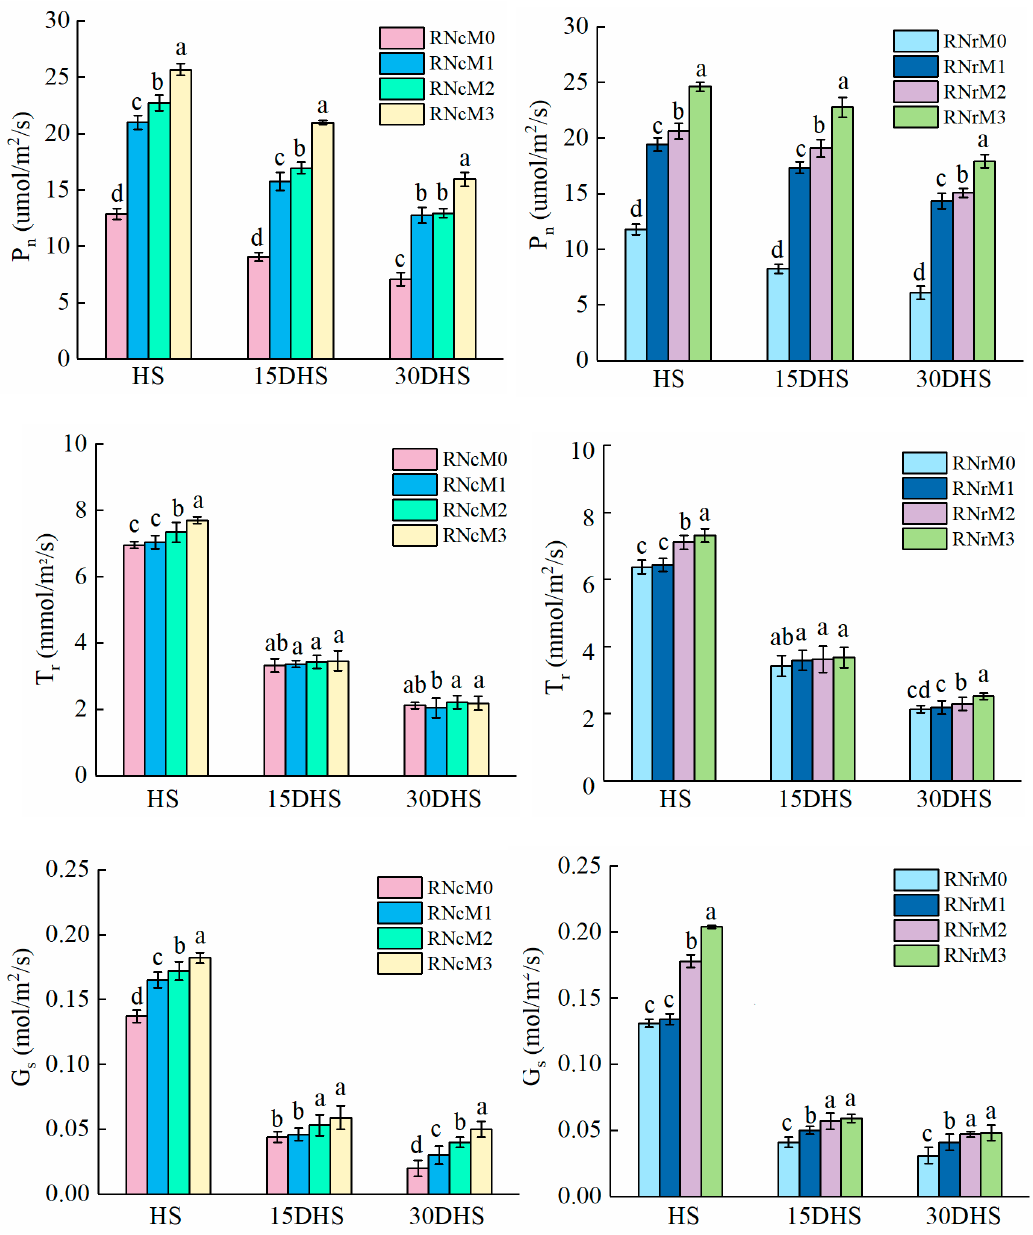
Figure 3. Effects of the N application rate during rapeseed season and N management during the rice season on the photosynthetic characteristics of the hybrid rice. Pn represents photosynthesis; Tr represents transpiration; GS represents stomatal conductance; R represents rapeseed; Nc and Nr represent the nitrogen fertilizer input of the rape season; M0, M1, M2 and M3 represent the nitrogen fertilizer operation in the rice season (0 kg N/hm 2 ) and conventional nitrogen applications (150 kg N/hm 2 ), respectively. HS represents heading stage; 15DHS represents 15 days after heading stage; 30DHS represents 30 days after heading stage. Lower case letters indicate that the photosynthetic characteristics of the hybrid rice are significantly different with the different treatments ( p < 0.05, LSD method).